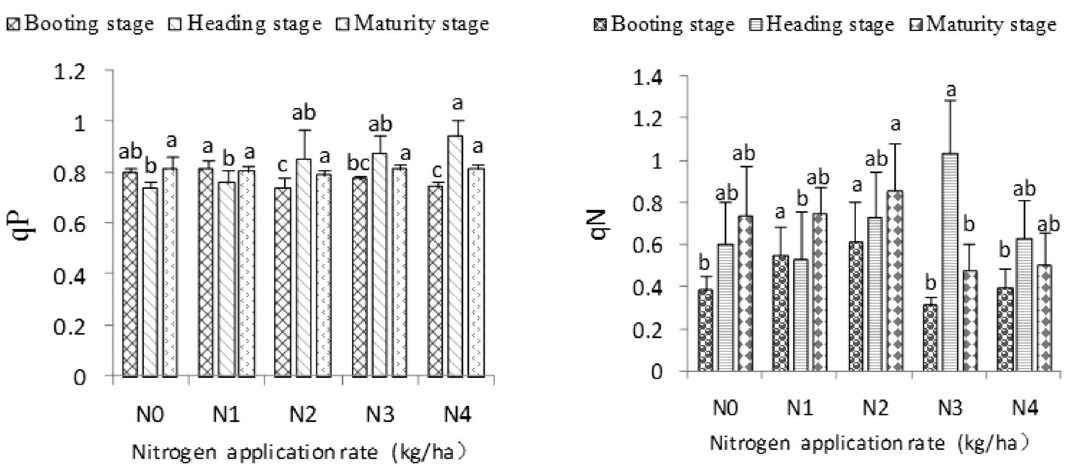
Figure 3. Effects of different nitrogen application rates on the fluorescence quenching coefficients of rice